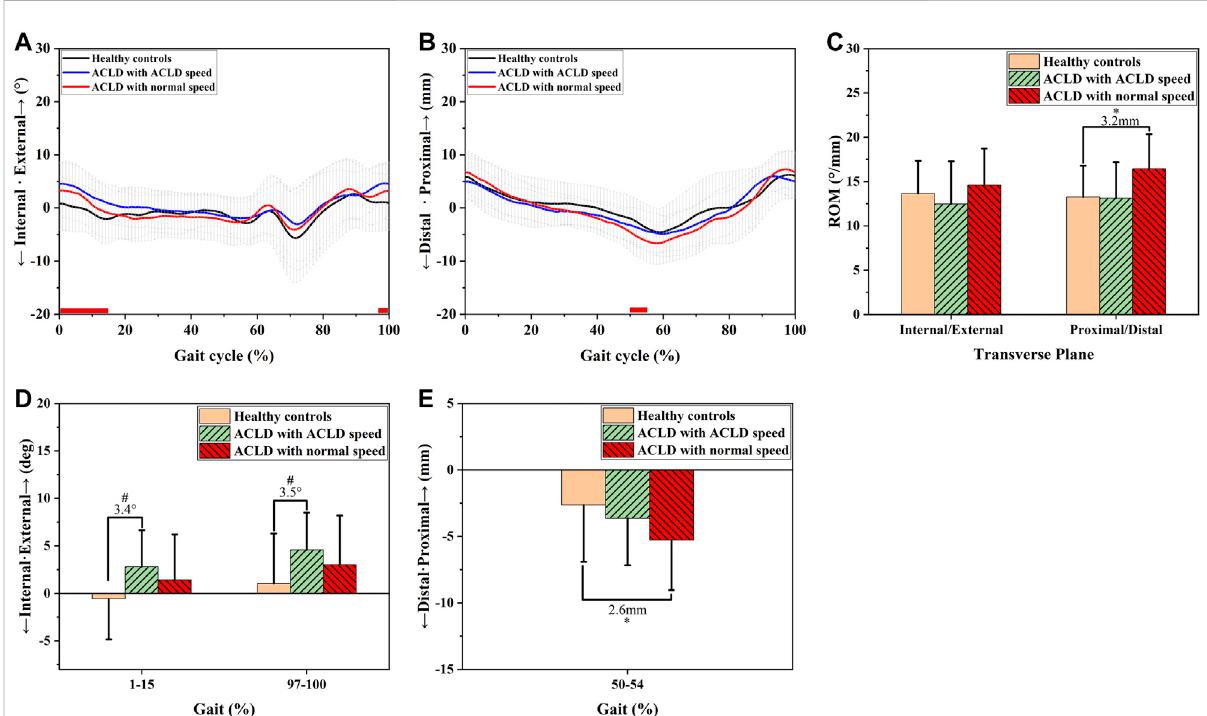
FIGURE 4 Transverse knee kinematic alterations of healthy controls and ACLD patients during gait. Chart (A,D) show walking internal/external tibial rotation angle alterations of ACLD patients at ACLD speed and the speed level of healthy controls (normal speed) compared to healthy controls. Chart (B,E) show walking distal/proximal tibial translationalterations ofACLD patientsatACLD speed andthespeedlevel ofhealthycontrols(normal speed) compared to healthy controls. Chart (C) shows the range of motion of internal/external tibial rotation angle and distal/proximal tibial translation of ACLD patients compared to healthy controls during walking. # Signi fi cant kinematic differences were found in ACLD patients who walkedatACLDspeedcomparedtohealthycontrols.*Signi fi cantkinematicdifferenceswerefoundinACLDpatientswhowalkedatthesamespeed level as healthy controls (Normal speed) compared to healthy